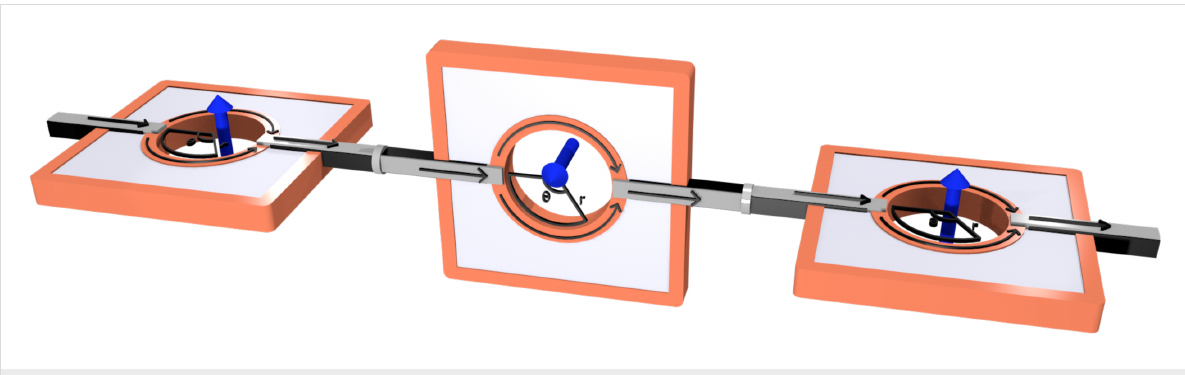
Figure 2: Three solid-state SG spin splitters in series, with the middle device at an angle π /2 relative to the other